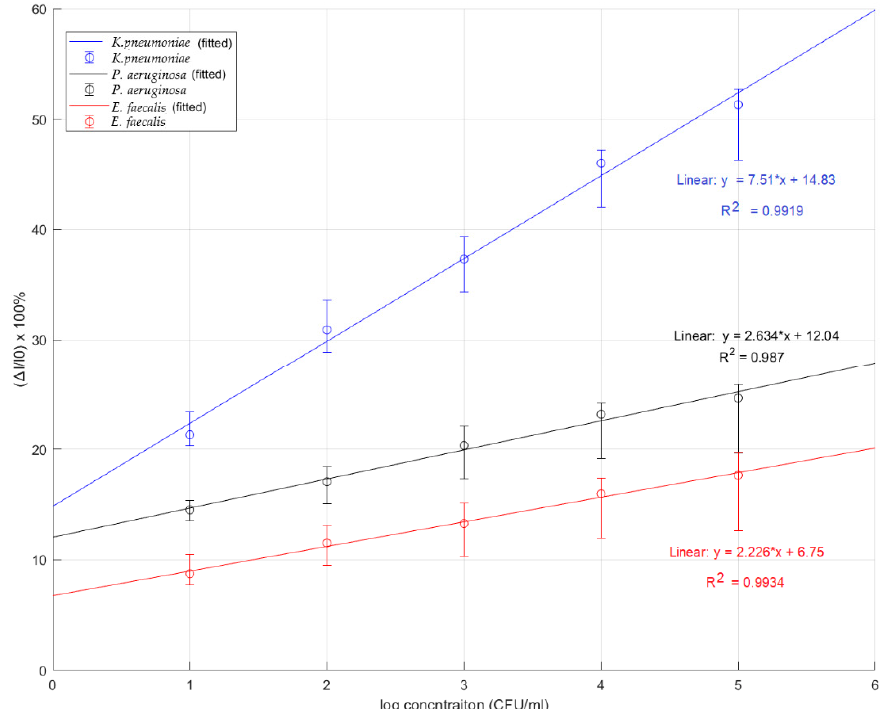
Figure 7. The plot of current changes as a linear function of log K. pneumoniae concentration gains from MIP composite on the gold electrode compared with the results from the control experiments using P. aeruginosa and E. faecalis. The number of replicated measurements is 3. (* is referred to mul- tiplication)